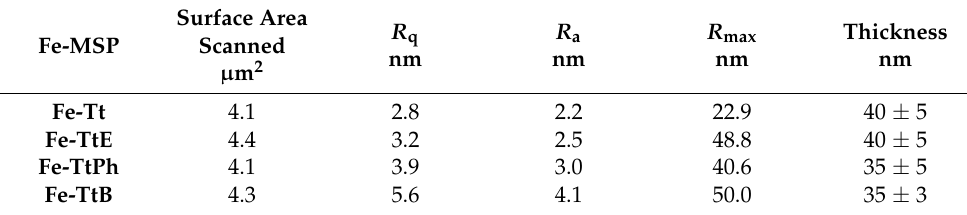
Table 2. Characteristics of Fe-MSP films spin-coated on ITO substrate. R q is the root mean square roughness; R a the average roughness and R max the maximum